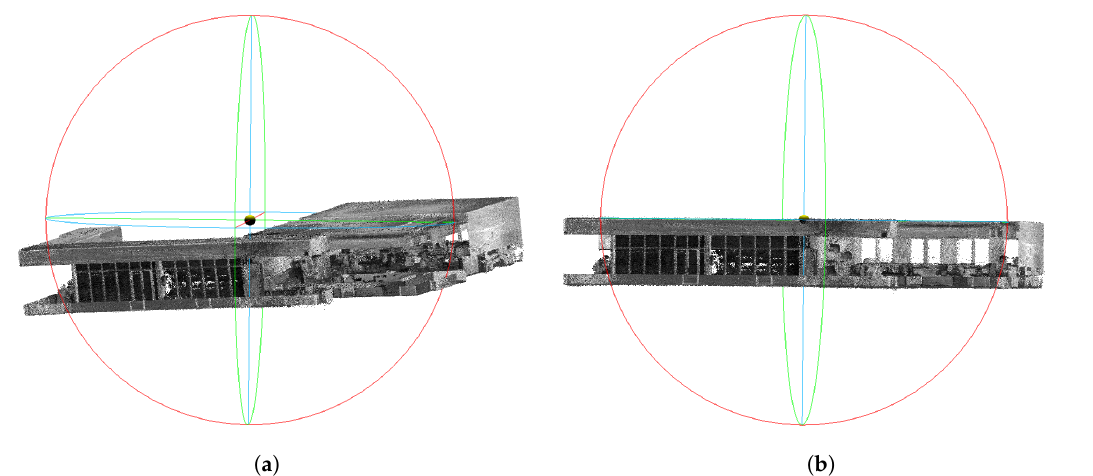
Figure 17. The reconstruction built by our SLAM solution before ( a ) and after ( b ) the alignment of horizontal planes (floor, ceiling, etc.) with XY plane (blue